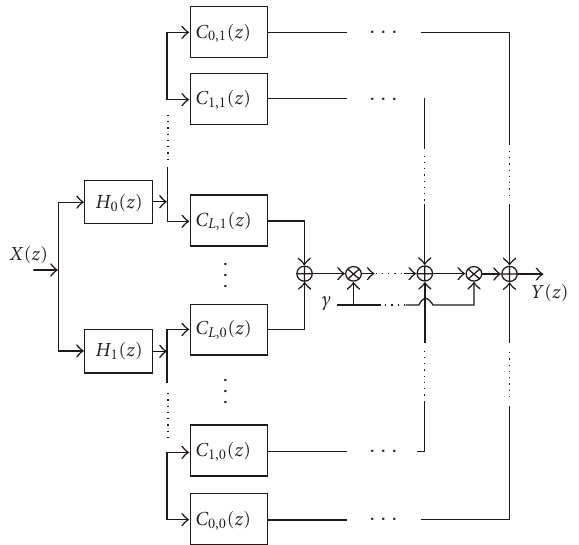
Figure 5: Resulting proposed structure.